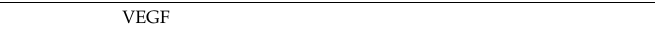
presence of portal vein thrombosis ( p <